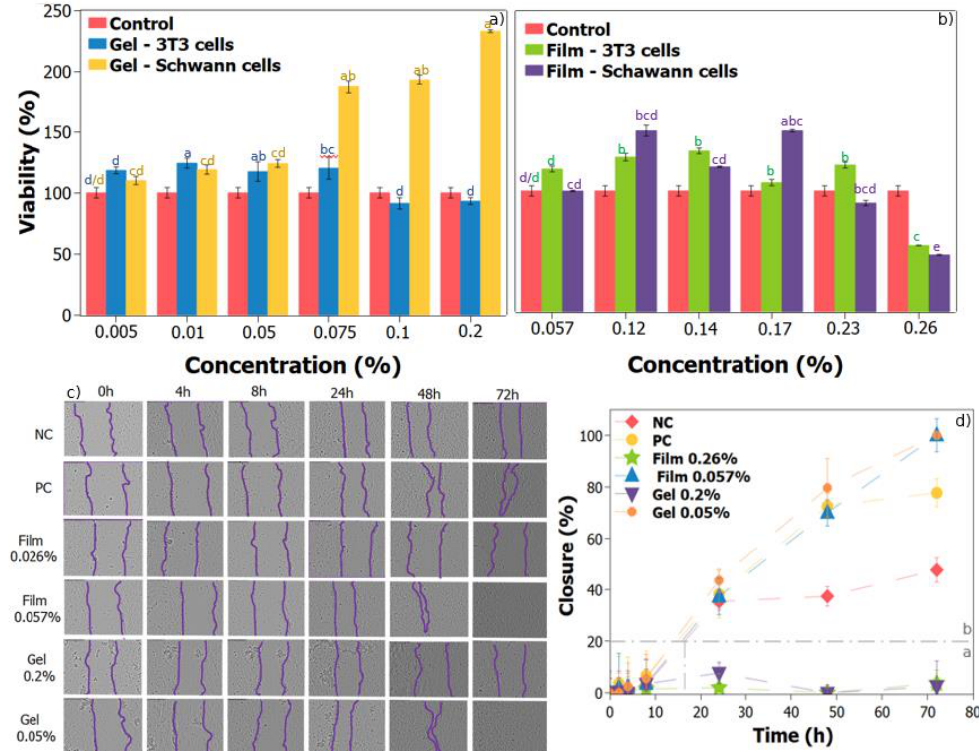
Figure 6. In vitro cytotoxicity assay ( a ) samples tested with 3T3cells and Schwann cells to the gel of Pinhão; ( b ) samples tested with 3T3cells and Schwann cells to film of Pinhão/PVA.; ( c ) Scratch assay in HaCaT cells over 72 h ( d ) results are expressed as mean ± standard error median of three independent experiments performed in triplicate. Medium with 10% FBS was used as positive control (PC) and medium without serum was used as negative control (NC); the measurements were performed considering the area of the scratch considering time 0 of each treatment with 0%. In ( a , b ) letters within the same color represent the Tukey post-hoc treatment for each specific test ( a – d ), samples that have the same letter are statistically equal, (blue — 3t3 cells in gel, yellow — Schwann cells in gel) ( p < 0.05). Control represented by another color is also compared statistically. Samples with the same letters within each color do not differ statistically. For ( d ) samples that were in region, b were statistically significantly different compared to samples in region ( a ).